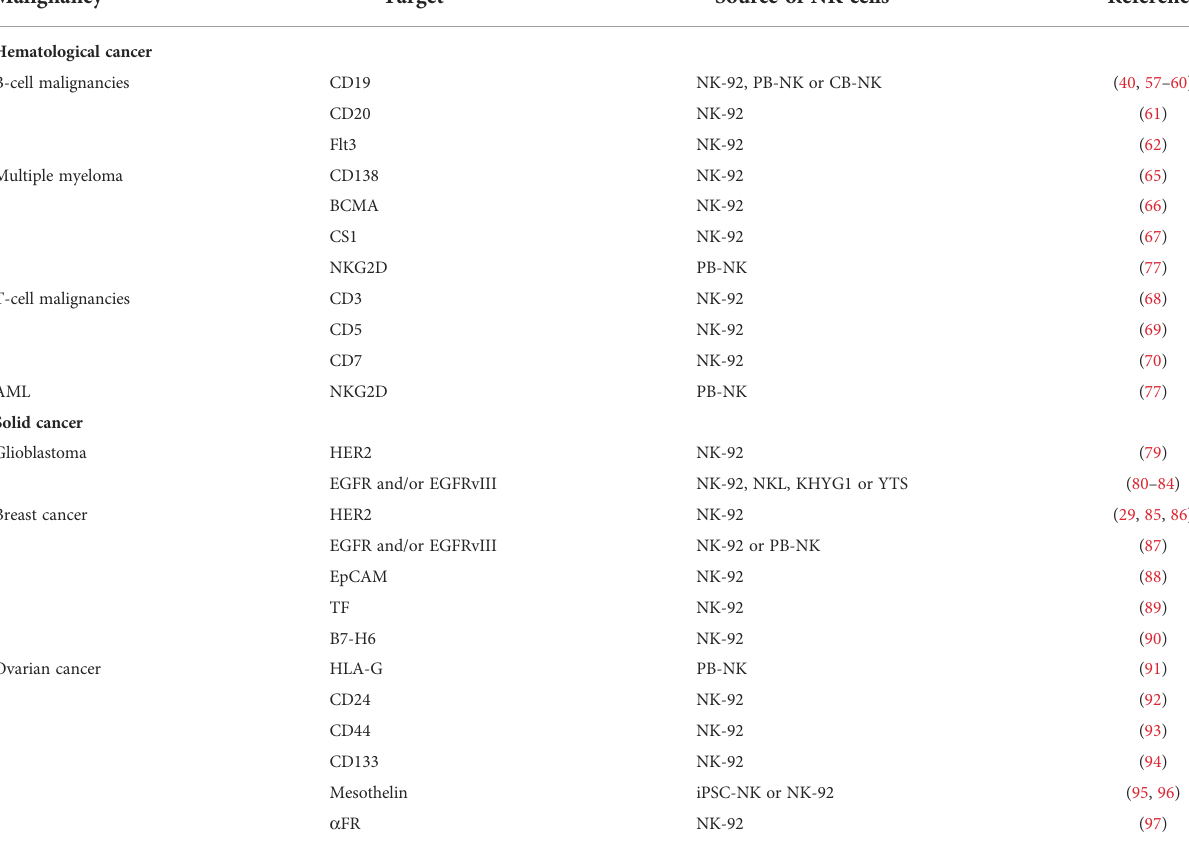
TABLE 1 Preclinical studies of CAR-NK cell